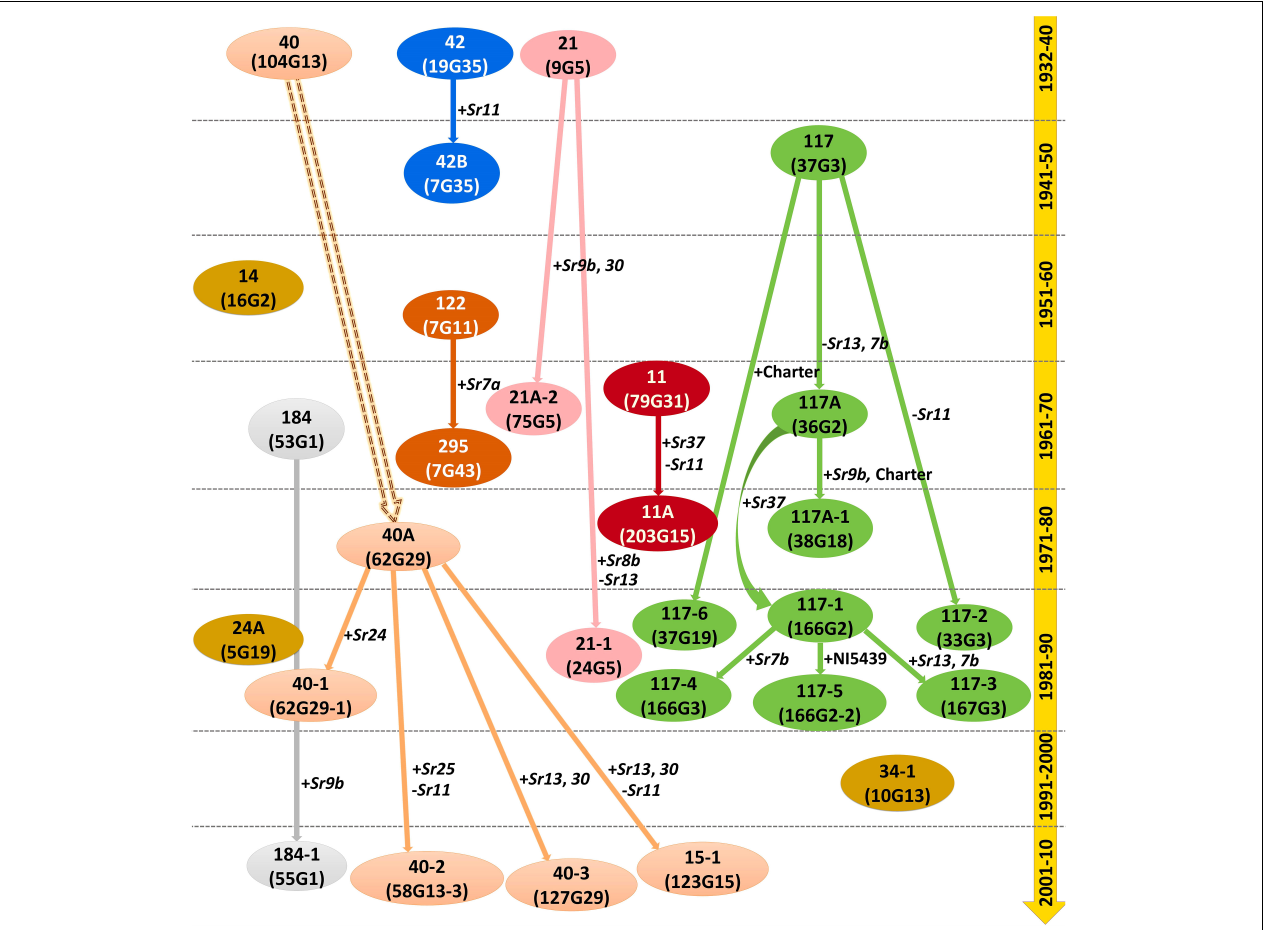
FIGURE 4 | Proposed virulence-based hypothetical evolutionary hierarchy of P. graminis f. sp. tritici pathotypes from the Indian subcontinent based on virulence phenotyping. Solid outlines explain the probability of mutations for gain or loss of virulence for the Sr genes indicated alongside. The parallel dotted lines indicated the timeline of pathotype evolution in